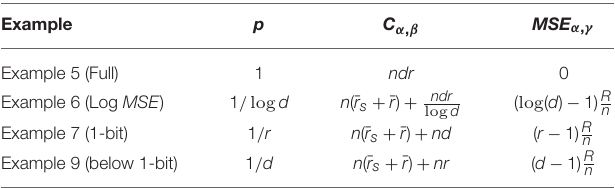
TABLE 1 | Summary of achievable communication cost and estimation error, for various choices of probability p